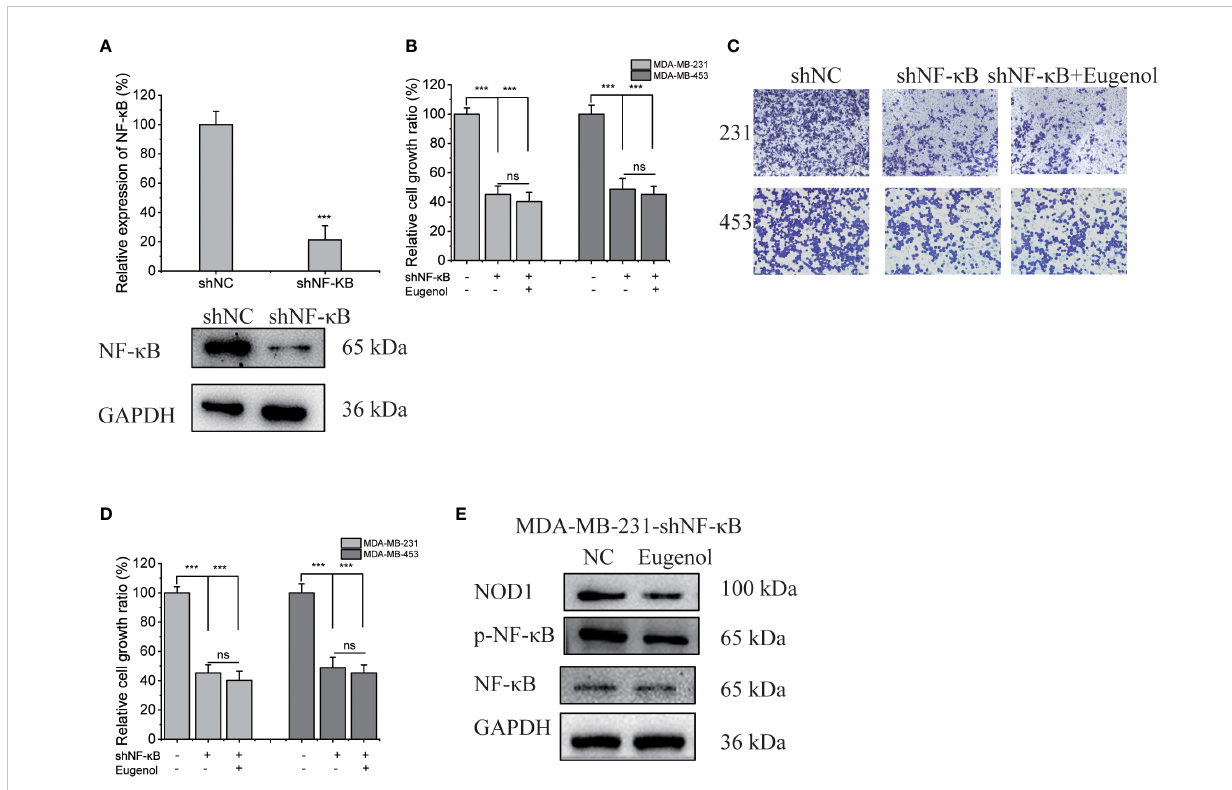
FIGURE 6 Veri fi cation of NF- k B as the target protein of eugenol in MDA-MB-231 cells. (A) Western blot experiment to verify the ef fi ciency of transfection of shNF- k B. (B) CCK8 experiment to explore the proliferation ability of eugenol on NF- k B knockdown MDA-MB-231 and MDA-MB-453 cells. (C, D) Transwell experiment to explore the metastatic ability of eugenol on NF- k B knockdown MDA-MB-231 and MDA-MB-453 cells. (E) The expression of NOD1 in NF- k B knockdown MDA-MB-231 cells with or without eugenol treatment. Data presented as mean ± SD, n = 3. ***P <